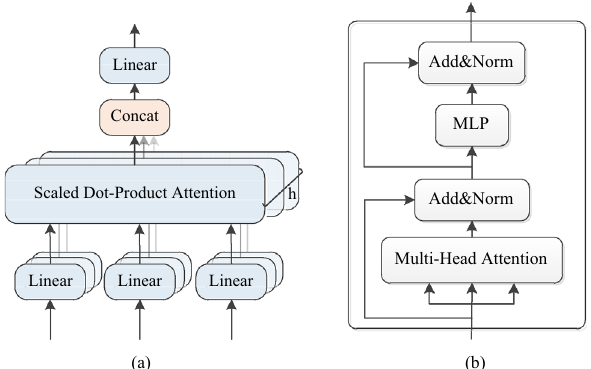
Figure 4. Structural diagram. ( a ) multi-head attention structure, ( b ) coding module in